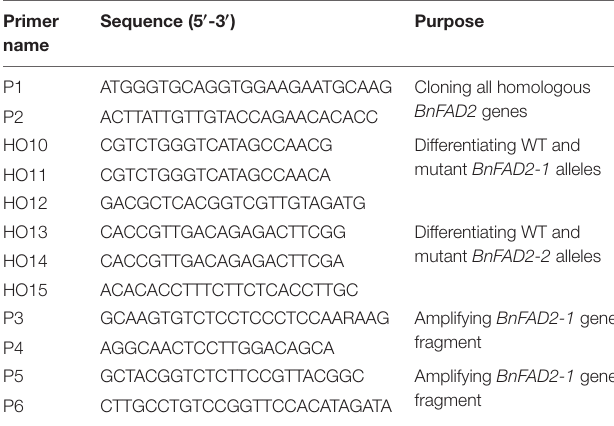
TABLE 1 | Primers used in this